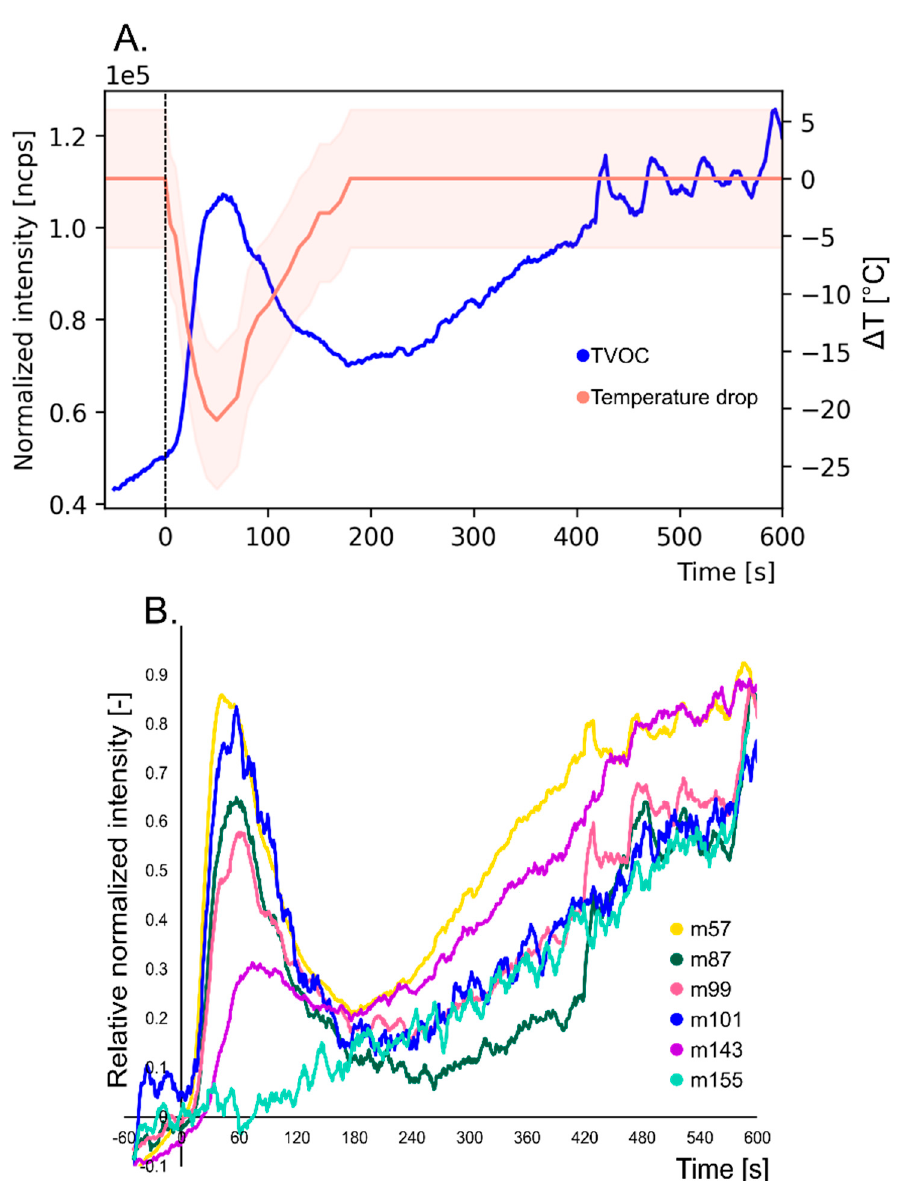
Figure 1. Emission profile of volatiles generated during potato cube deep-frying in rapeseed oil heated to 180 °C; ( A ) TVOC (total volatile organic compounds) changes during frying expressed as ncps and oil temperature drop during frying; ( B ) Selected ions, namely m57 (57.03 m / z ), m87 (87.08 m / z ), m99 (99.07 m / z ), m101 (101.10 m / z ), m143 (143.14 m / z ), m155 (155.14 m / z ) which represent SOPs (secondary oxidation products) emitted during deep-frying; start of frying at time 0